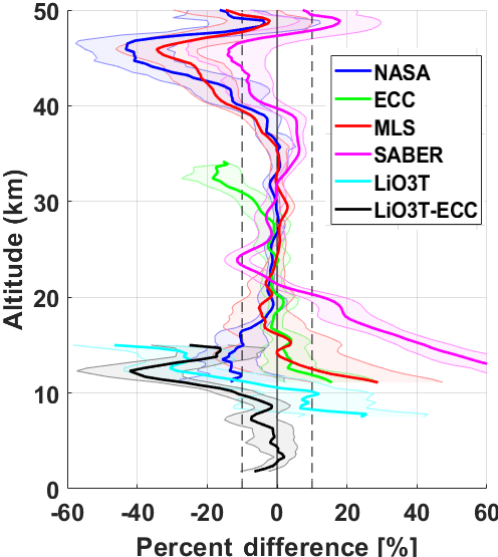
Figure 7. The average relative difference profile between the ozone profiles measured by the various LAVANDE instruments compared to the ozone profile measured by the LiO 3 S. The shaded range gives the ± 2 standard deviations of the mean and indicates the statistical confidence interval at the 95% uncertainty level. Results for MLS and SABER are reported using the weighted average profiles, but very similar results are obtained by using only the profile from the closest SABER or MLS